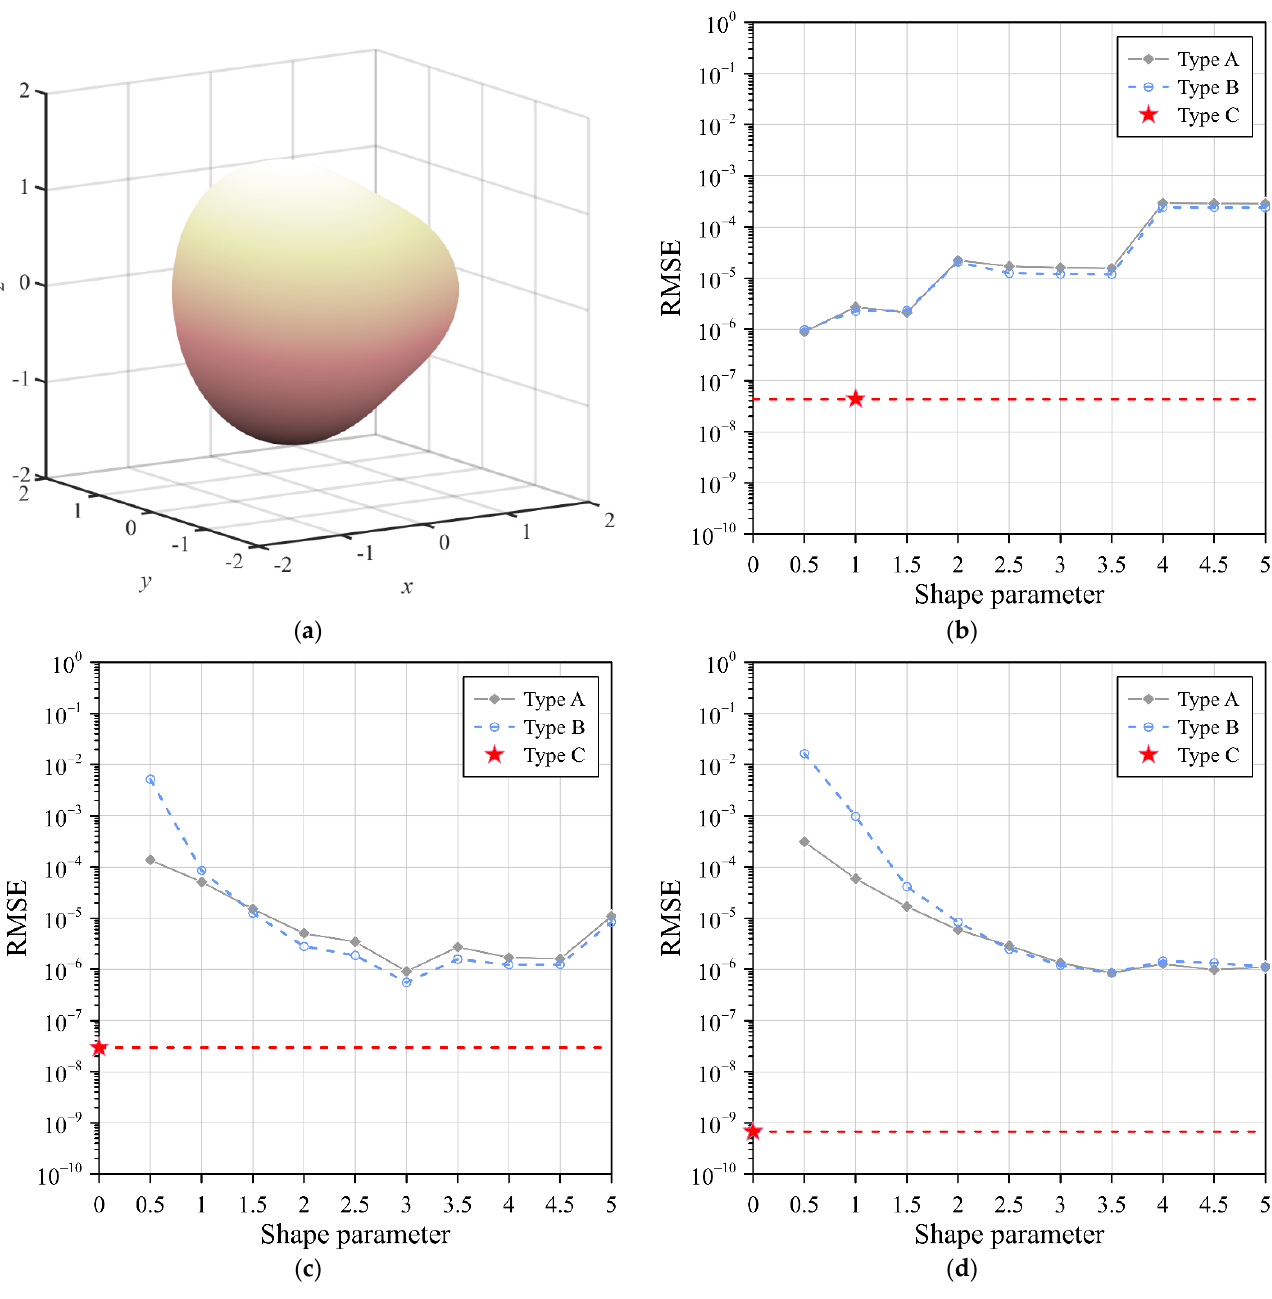
Figure 10. Problem domain and RMSEs of RBFs using three different collocation types: ( a ) problem domain, ( b ) Gaussian RBF, ( c ) MQ RBF, and ( d ) IMQ RBF.